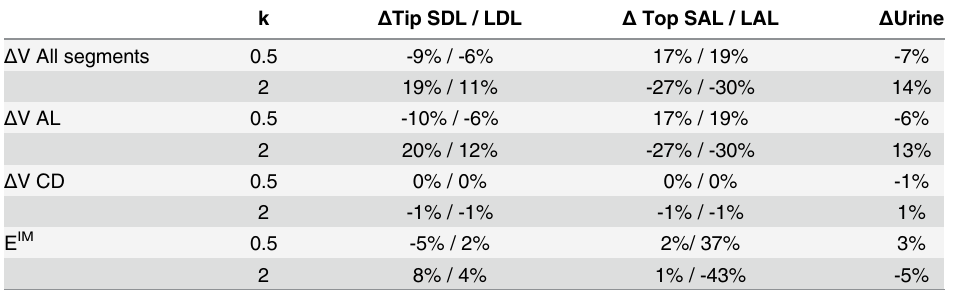
Table 1. Effects of electrical potential Δ V in the whole medulla and inner medullary external osmoles E IM on ammonia excretion. k Δ Tip SDL / LDL Δ Top SAL / LAL Δ Urine Δ V All segments 0.5 -9% / -6% 17% / 19% -7% 2 19% / 11% -27% / -30% 14% Δ V AL 0.5 -10% / -6% 17% / 19% -6% 2 20% / 12% -27% / -30% 13% Δ V CD 0.5 0% / 0% 0% / 0% -1% 2 -1% / -1% -1% / -1% 1% E IM 0.5 -5% / 2% 2%/ 37% 3% 2 8% / 4% 1% / -43% -5% Baseline value for each parameter is halved ( k = -0.5) or doubled ( k = 2). The results are presented as the percentage changes from baseline. The electrical potential has a small effect on urinary ammonia